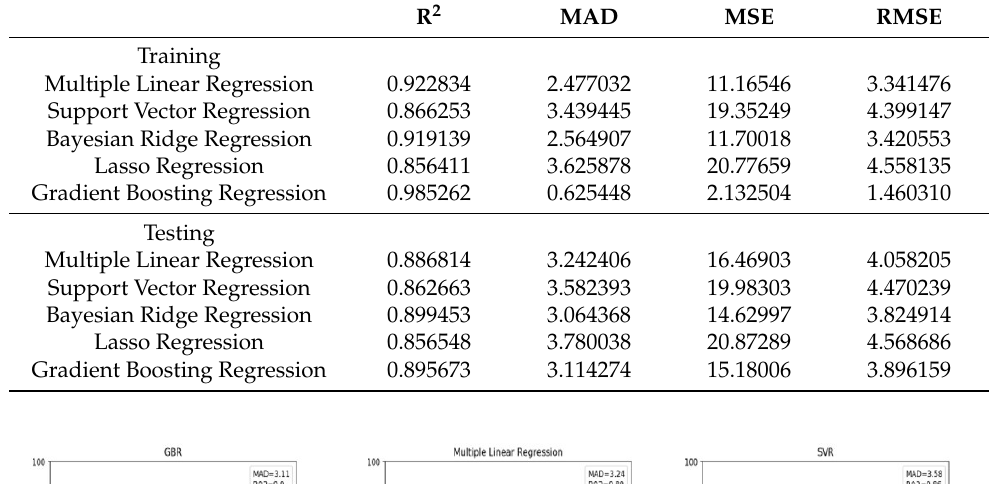
Figure 4. Comparison results between the actual age and predicted age by five different models on the training rheumatoid arthritis data. ( a ) gradient boosting regression, ( b ) multiple linear regres- sion, ( c ) support vector regression, ( d ) Bayesian ridge regression and ( e ) lasso regression.